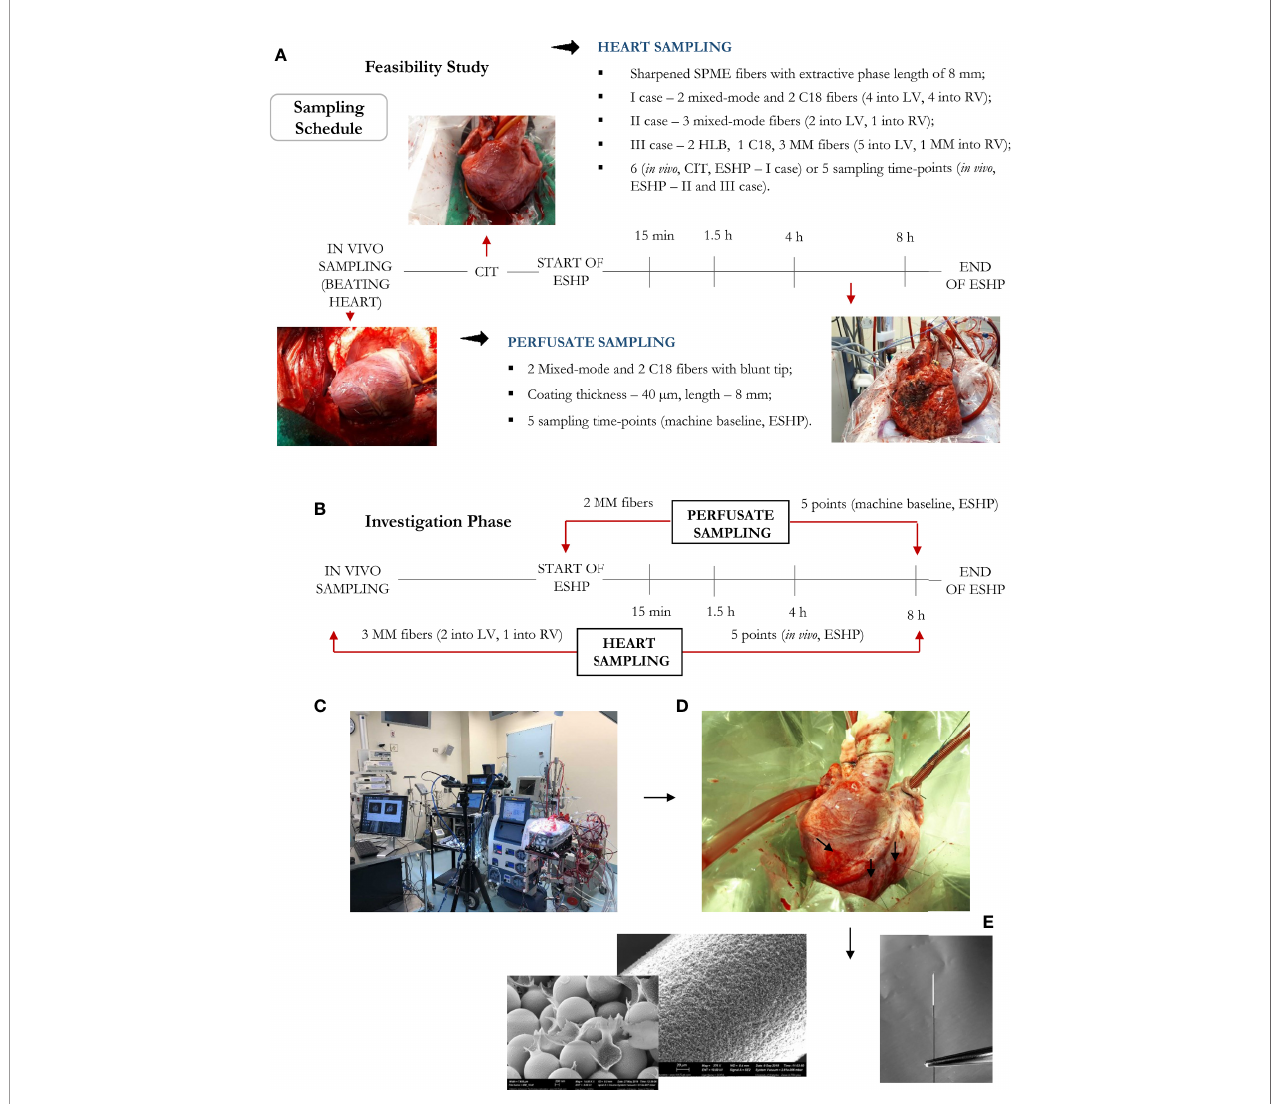
FIGURE 1 | Bio-SPME sampling of porcine hearts during ex situ heart perfusion (ESHP). Time schedule of heart and plasma/perfusate sampling for the (A) feasibility and (B) investigation phases. Photograph of the ESHP circuit (C) together with solid-phase microextraction (SPME) microprobes applied for in / ex vivo and non-destructive sampling of small-molecular-weight molecules (D) . Insertion of a microprobe the size of an acupuncture needle (0.28 mm diameter) into cardiac tissue such that its entire 8 mm coating is immersed. Enlarged images of SPME fi bers with a sharpened tip were presented (E) . The SPME probe enables minimally-invasive/non-destructive sampling, and is manufactured from fully biocompatible